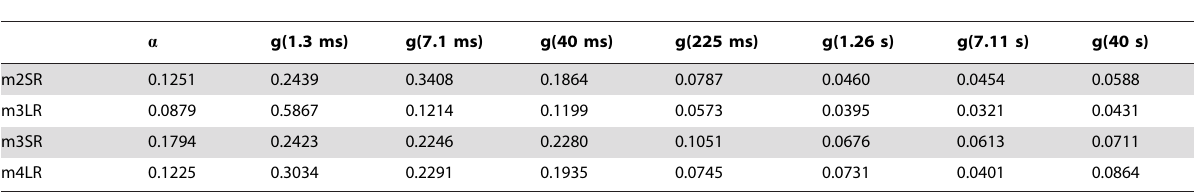
Table 2. Parameters for the QLV model (average fit for each muscle).